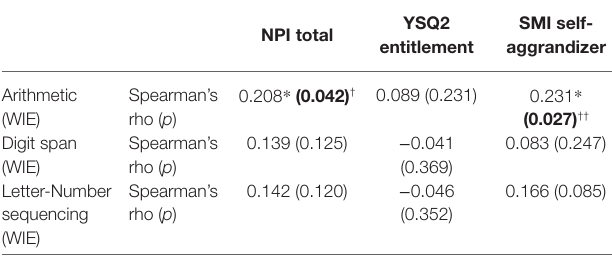
TABLE 1 | Correlation analysis of narcissism measures narcissistic personality inventory (NPI, 40-item version), YSQS2 entitlement scale and SMI self- aggrandizer scale with working memory scores of Wechsler Adult Intelligence Scale (WIE) in n = 70 psychiatrically healthy